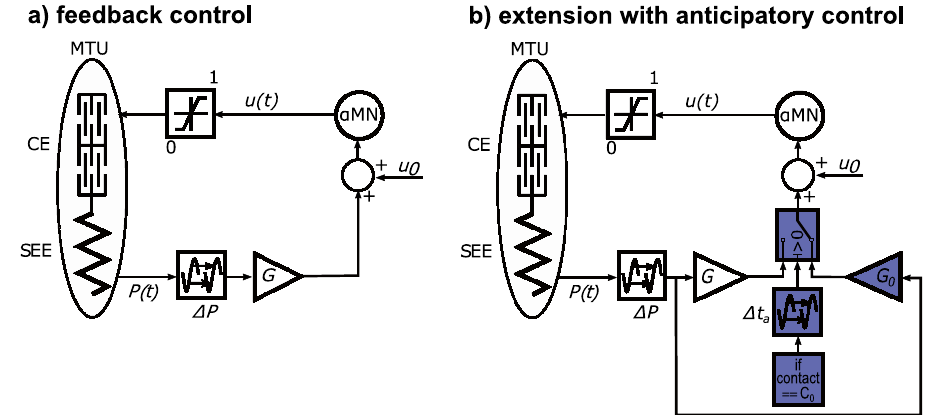
Figure 2. Block diagrams of ( a ) the original reflex-based walking model of Geyer and Herr 13 and ( b ) the extension for the application of an anticipatory strategy. In both diagrams, the feedback signal P ( t ) from the muscle–tendon unit (MTU) is time-delayed ΔP , gained ( G ), and added to a constant stimulation bias ( u 0 ). The resulting stimulation signal ( u t ) is transmitted back to the muscle via a -motor neuron ( aMN ) and can only assume values in the range between 1 and 0. The extension is characterized by counting the ground contacts of the left leg. At the preparatory step C 0 , the reflex gain G is switched to the anticipatory gain G 0 . If Δt a = 0, the anticipatory gain is active from heel strike of C 0 (early anticipation), while late anticipation is implemented with Δt a = 0.3 s. Adopted with permission from Geyer and Herr